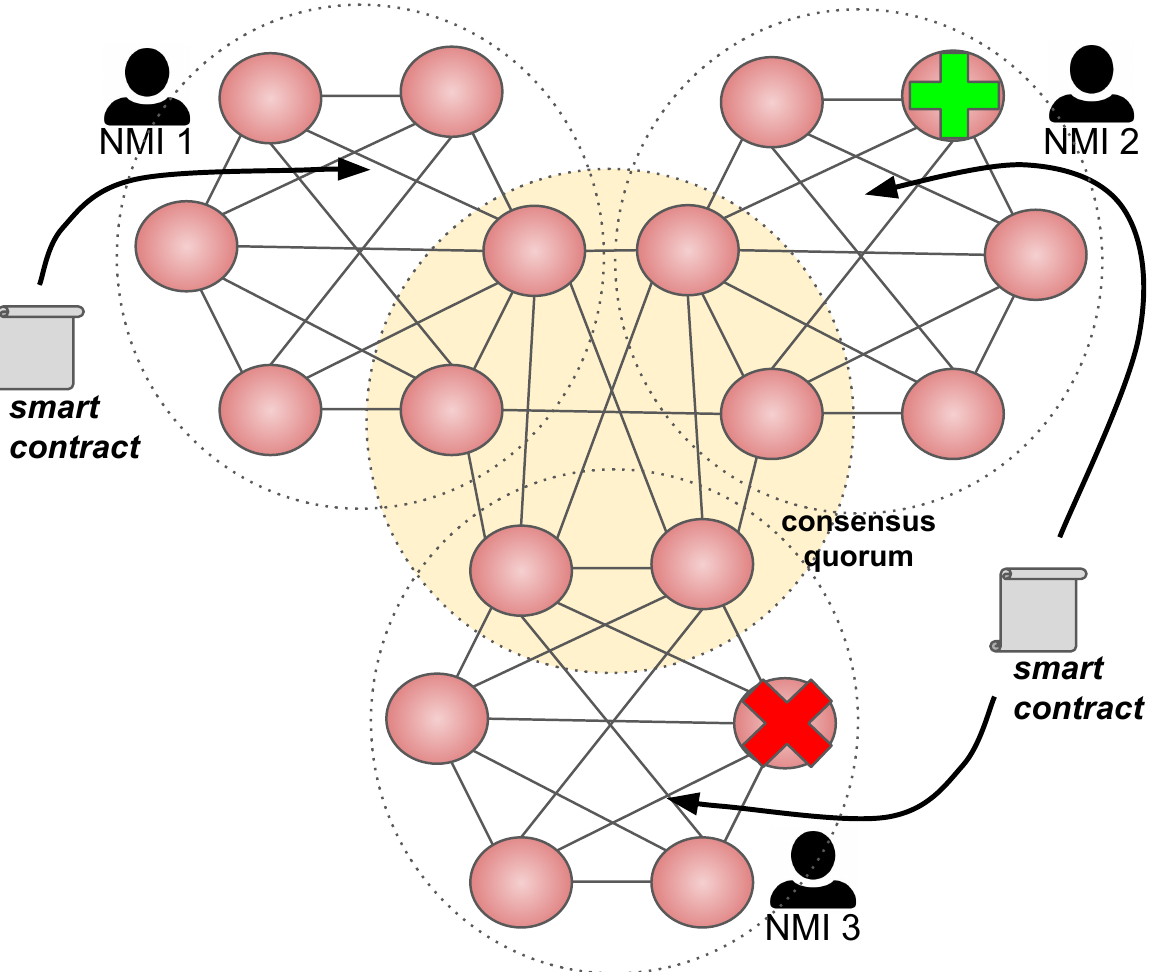
Figure 1. An inter-National Metrology Institute (NMI) blockchain network with a decentralized and permissioned